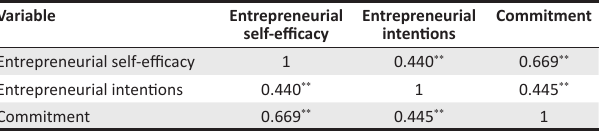
TABLE 3: Pearson’s correlation analysis.